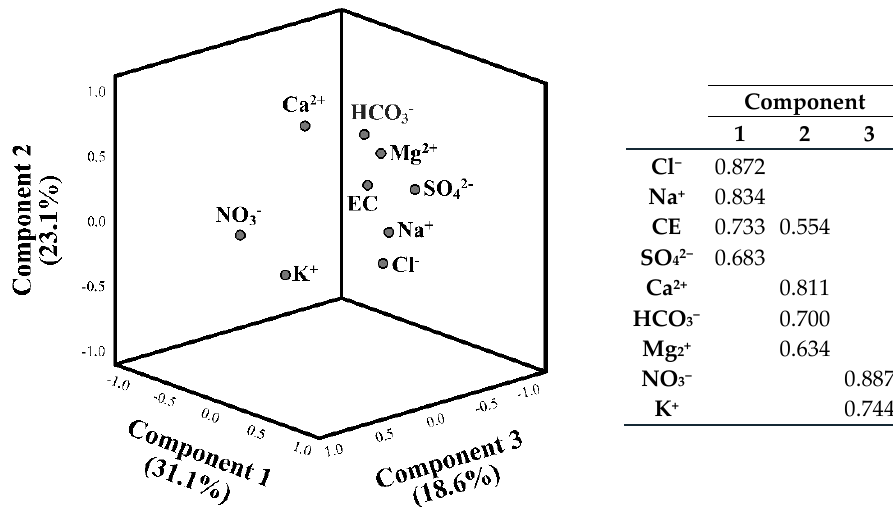
Figure 3. Principal Component Analysis (PCA) component plot in rotated space ( left ) and rotated component matrix ( right ). Percentages below the components indicate the percentage of variance explained.